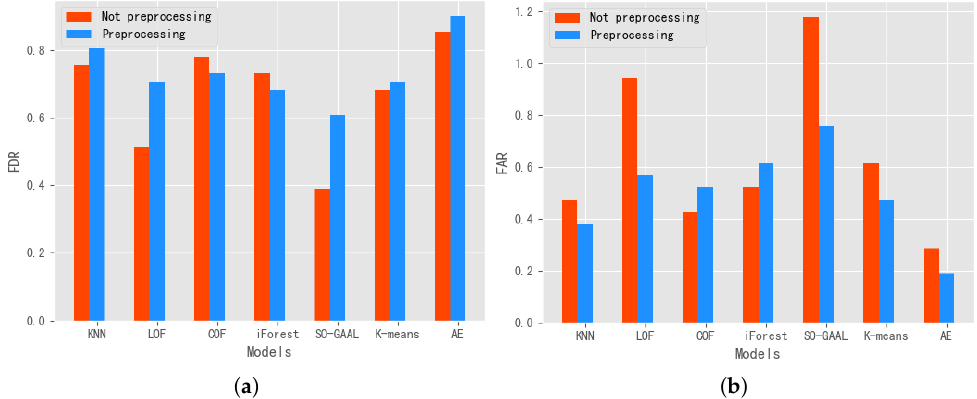
Figure 7. Performance of FDR and FAR for each model with preprocessing or not. ( a ) FDR. ( b ) FAR.